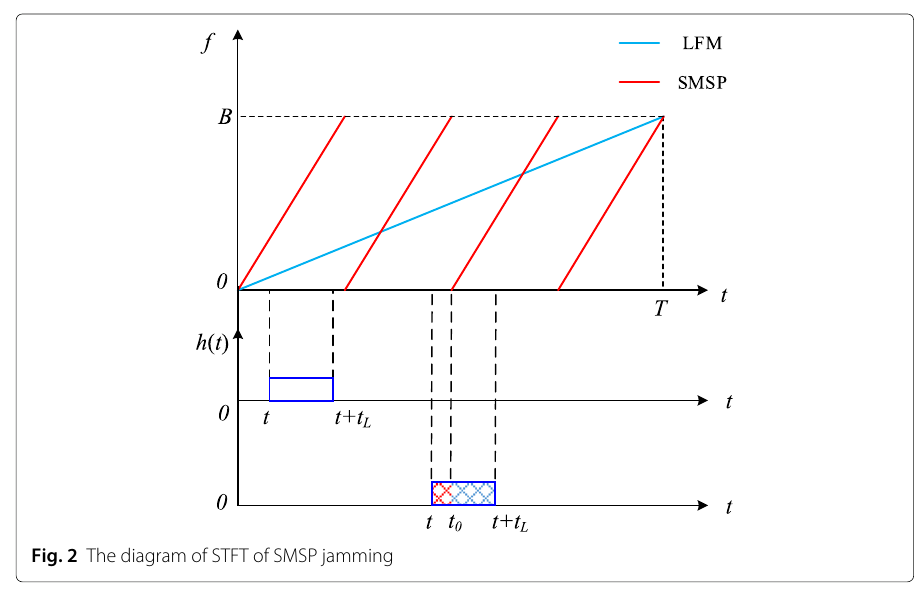
Fig. 2 The diagram of STFT of SMSP